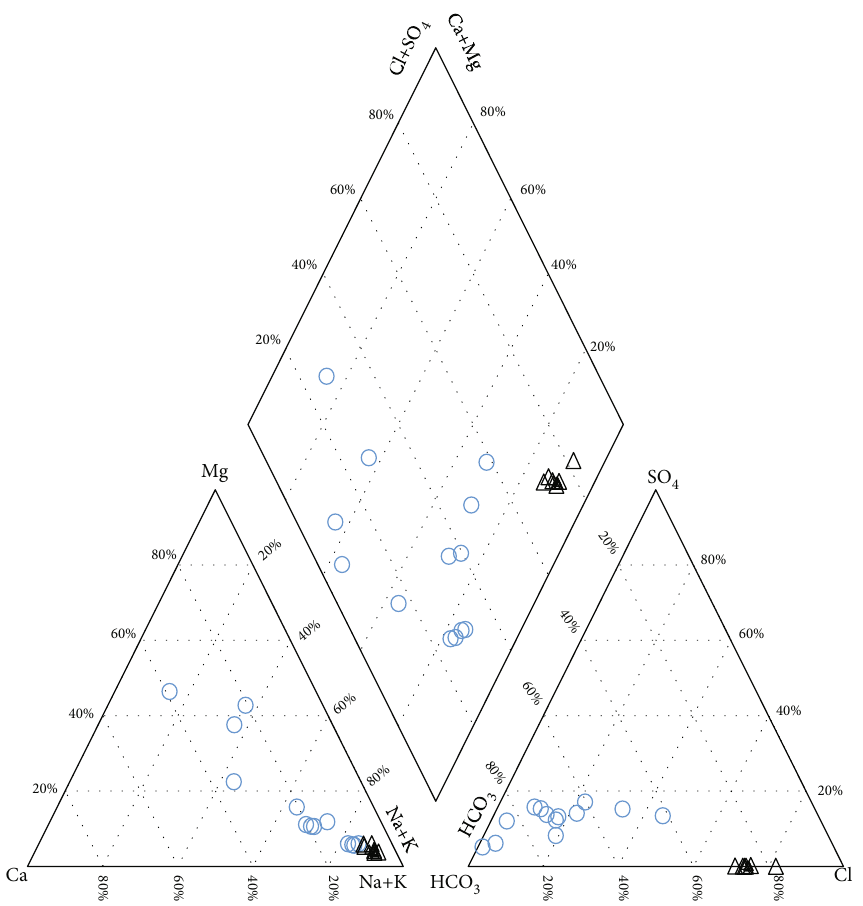
Figure 5: Piper diagram of groundwater at Xiongxian geothermal site. Black open triangles: hot groundwater; blue open circles: cold groundwater.